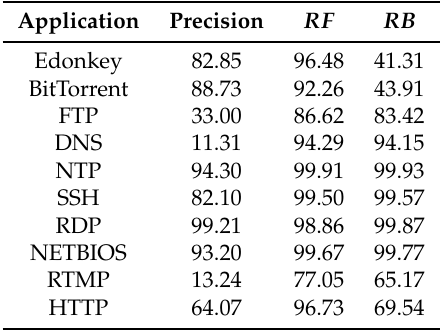
Table 8. S-MODC results for Precision, Recall in Flows ( RF ), and Recall in Bytes ( RB ).